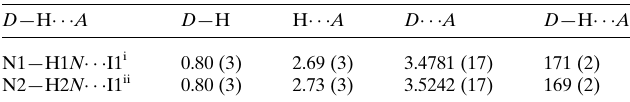
Table 1 Hydrogen-bond geometry (A˚ , (cid:4) ).